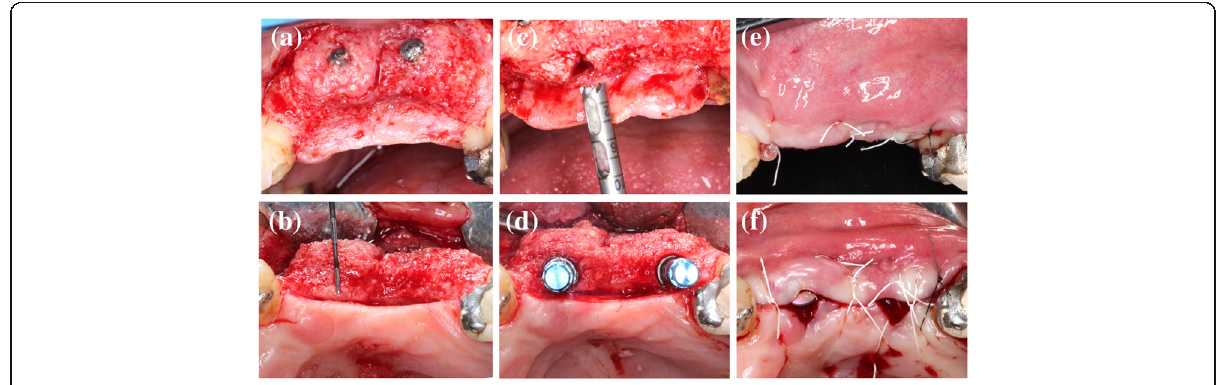
Fig. 3 Re-entry procedure of patient in Fig. 1. a Buccal aspect of the augmented region. b Horizontal bone augmentation. c Screws and pins removal and bone trephine sampling. d Implants placement and buccal bone width from the implant shoulder. e Primary flap closure. f Implants submerged